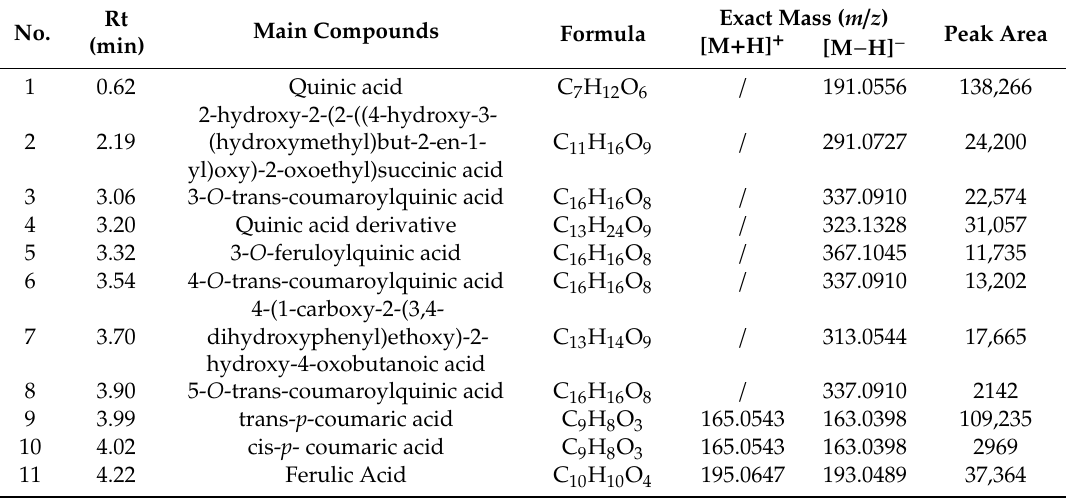
Table 2. Identification of chemical constituents from C. rotundus aqueous extracts.